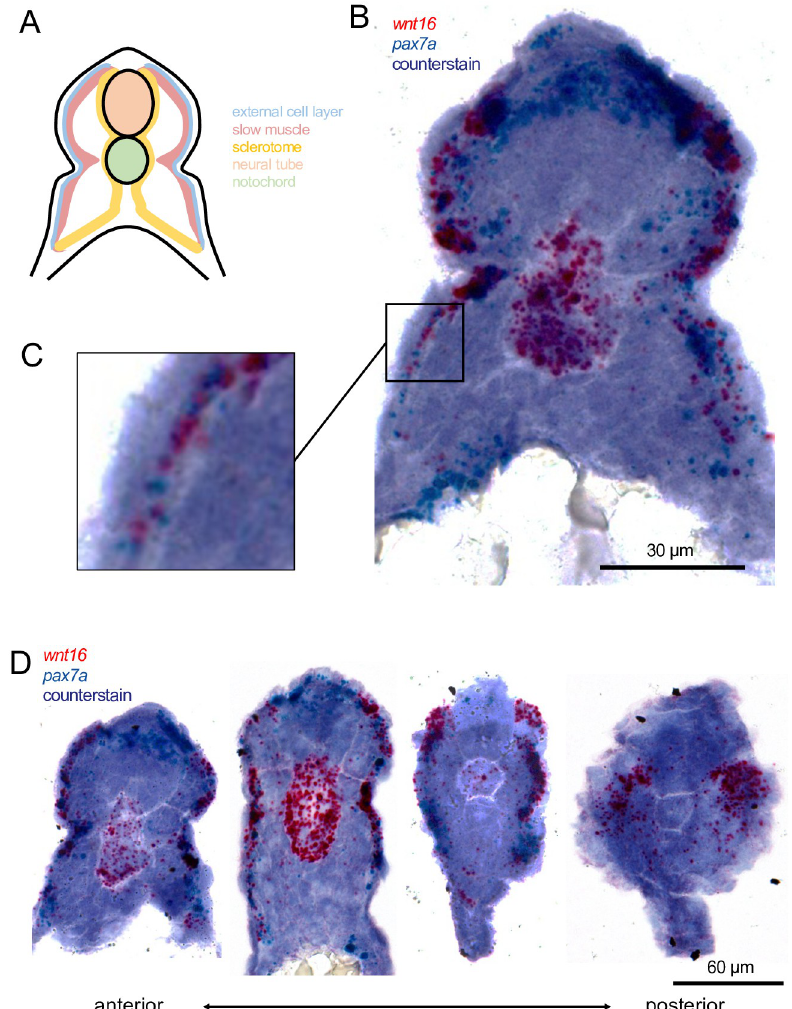
Fig 2. wnt16 is expressed in dermomyotome-like cells at 22 hpf. (A) A schematic of a transverse section through the zebrafish trunk with compartments labeled and color coded. (B-C) Chromogenic in situ hybridization of an anterior (note the yolk in the ventral space) transverse section through the zebrafish trunk shows cells expressing wnt16 and pax7a are located in the external cell layer (magnified in C). (D) Transverse sections, beginning in the anterior trunk (left), and moving posteriorly (right), representing less mature somites, show variation in wnt16 + labeling.